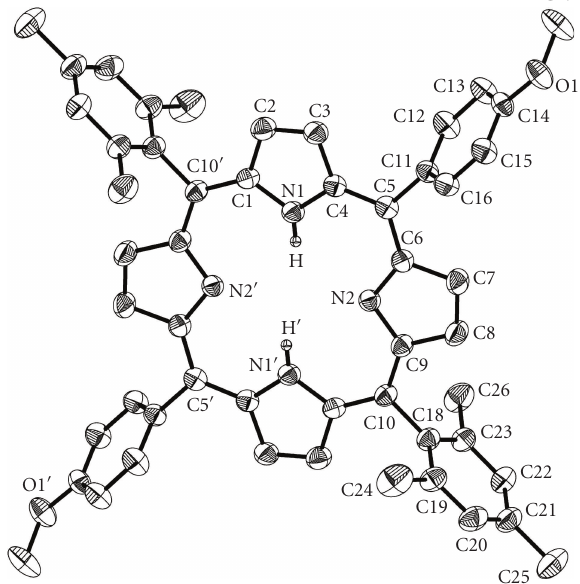
Table 2: Crystallographic data for 4 2H 2